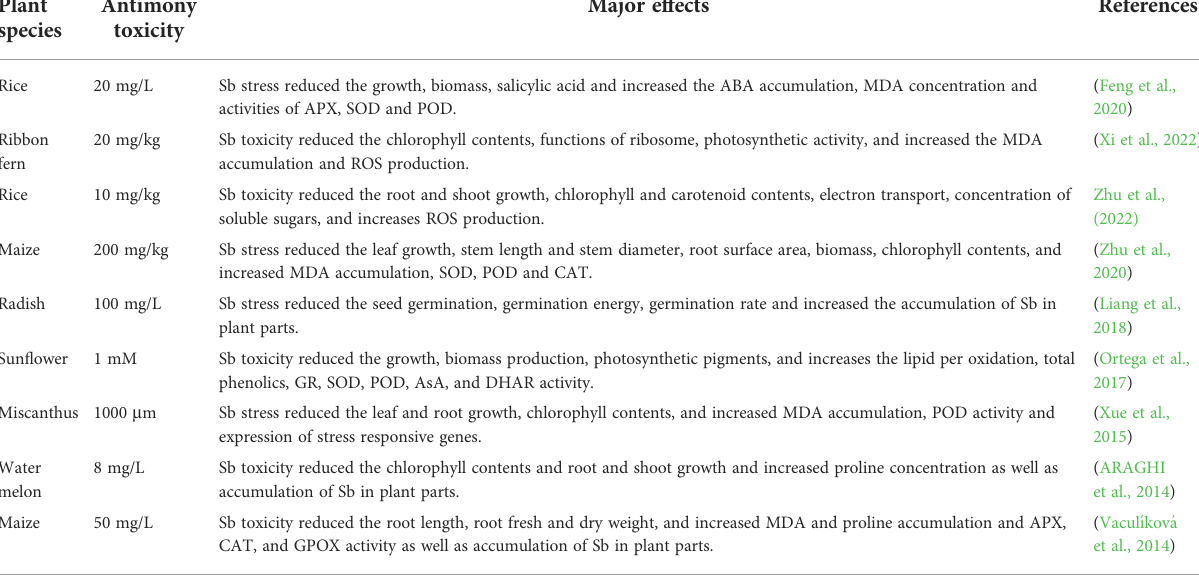
TABLE 3 Effects of antimony stress on growth, oxidative stress markers and antioxidant activities of different plant species. Plant